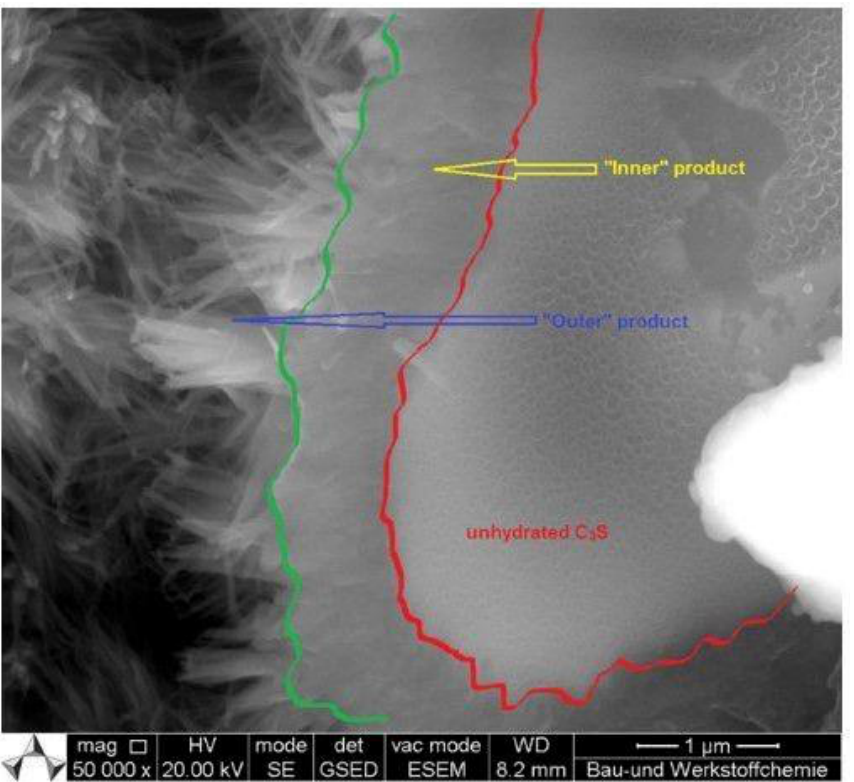
Figure 4. SEM micrograph showing the two types of C-S-H produced during hydration; namely, the “outer” product away from the cement particle surface, occupying the water-filled space and characterized by high porosity, and the “inner” C-S-H formed during later steps of hydration and characterized by low porosity. Reprinted with permission from [77].